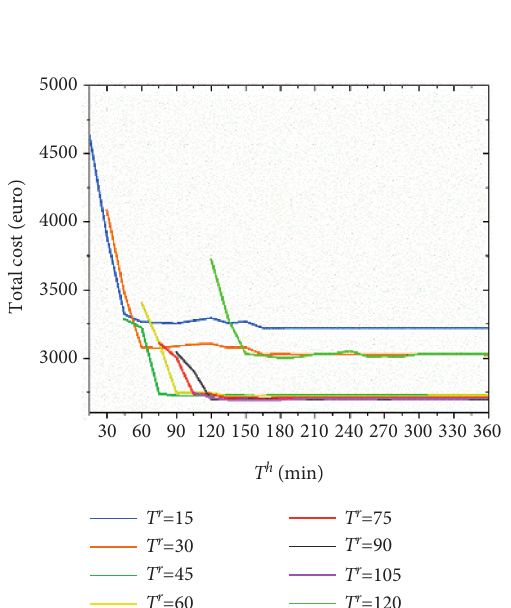
Figure 11: Results of distance reduced by ridesharing.